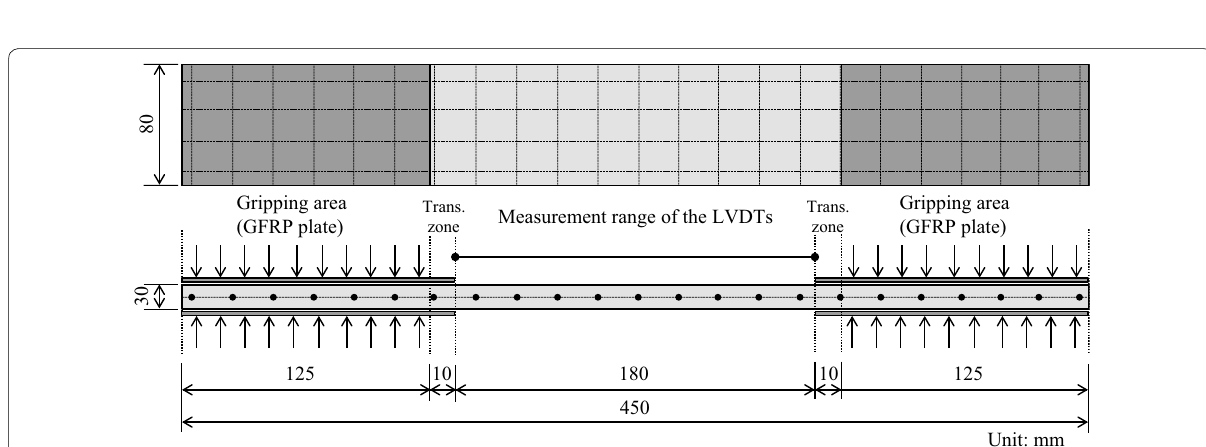
Fig. 2 Typical details of test